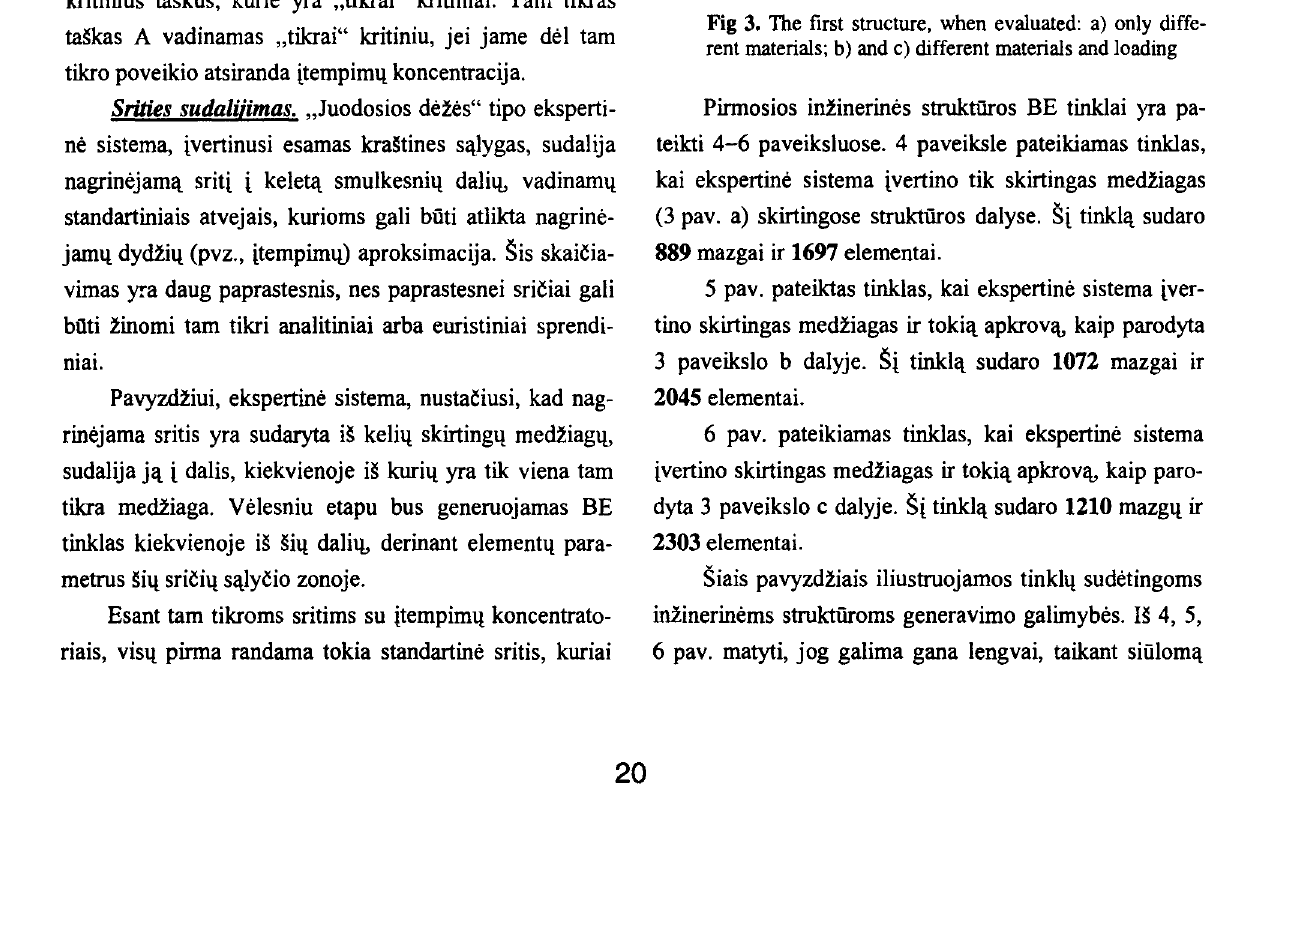
Fig 2. Schematic diagram of the black box system Ziniq bazei atnaujinti reiketq prideti papildomas tai sykles, apibrefiancias naujai pridedamus iini~ saltinius. Kritiniu regionu Hrinkimas. Nuskai6usi visa. rei kiama. informacija. apie nagrinejamos srities geometrijll, krMtines sa.lygas, apkrovim<L medZiagos pasiskirstymll,